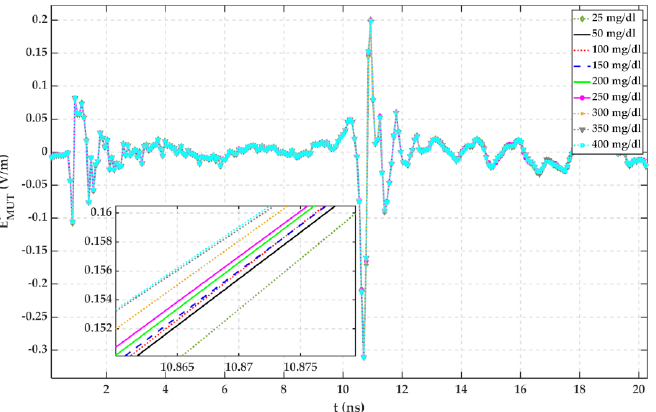
Figure 13. Reflected signal differences of various MUTs concerning water with 25 mg/dL glucose (measured with m-sequence radar).